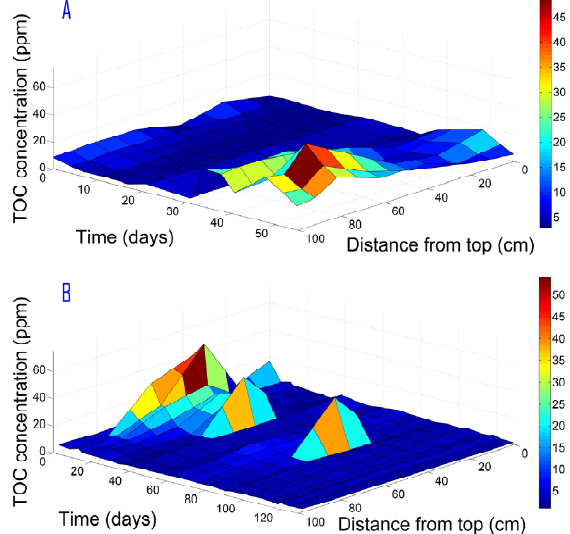
Figure 6. Total organic carbon (TOC) concentration as a function of time and distance along the column in ( A ) Phase I and ( B ) Phase